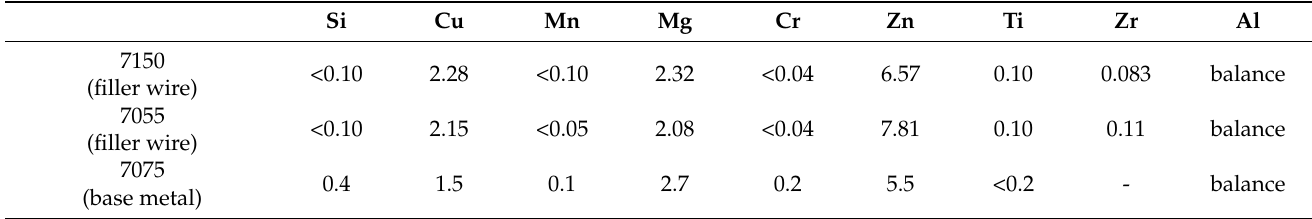
Table 1. Compositions of base metal and filler wire